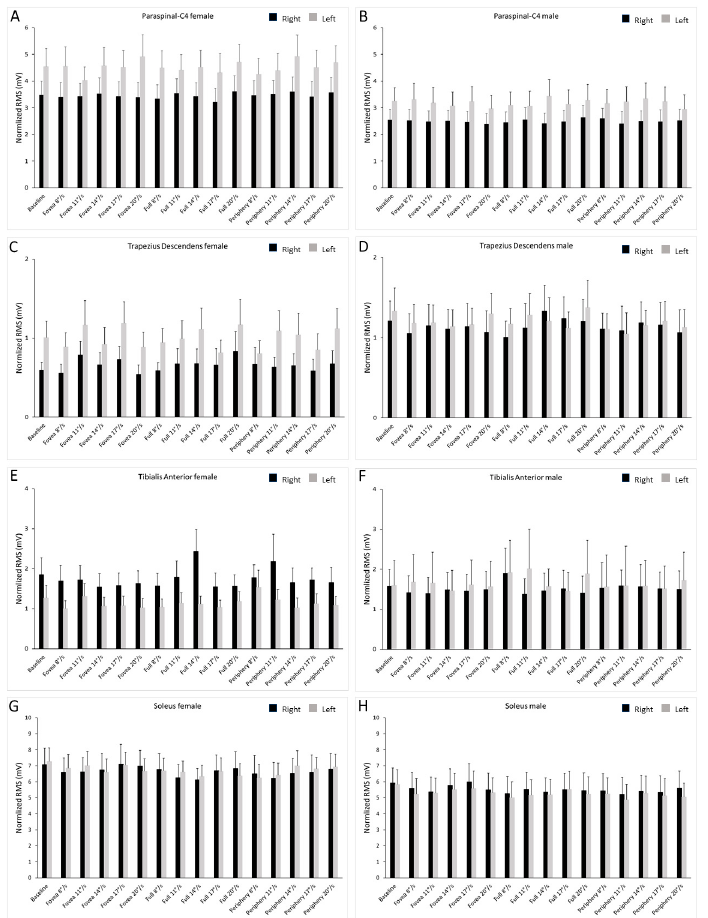
Figure 2. Bar graph of normalized EMG traces in the left and right limb of male and female subjects. Values are shown during optic flow stimuli at different speeds and baseline. The black bars represent the right muscles, and the gray bars represent the left muscles. Data are shown as mean ± SE. ( A ) Activity of the paraspianal-C4 in females. ( B ) Activity of the paraspianal-C4 in males. ( C ) Activity of the trapezius descendens in females. ( D ) Activity of the trapezius descendens in males. ( E ) Activity of the tibialis anterior in females. ( F ) Activity of the tibialis anterior in males. ( G ) Activity of the soleus in females. ( H ) Activity of the soleus in males.